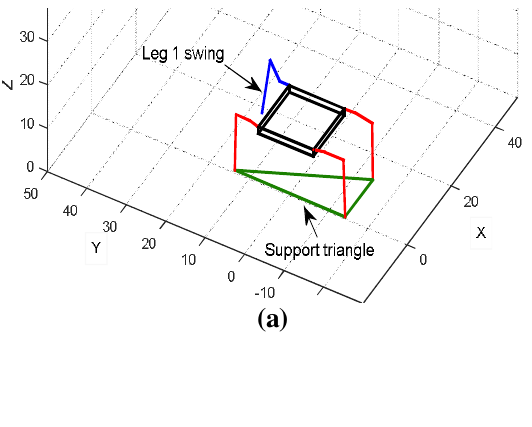
Fig. 14. Showing (a) Leg 3 in swinging phase. (b) The stability margin (cm) when leg3 is swing. vw D